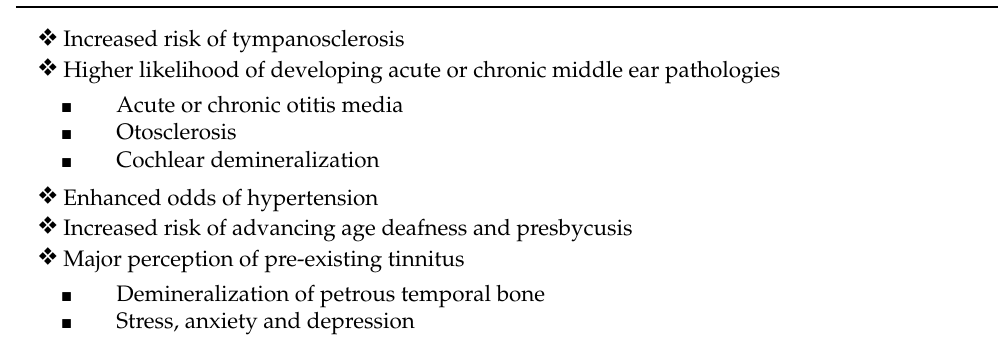
Table 2. Mechanisms by which low serum vitamin D levels may trigger or aggravate